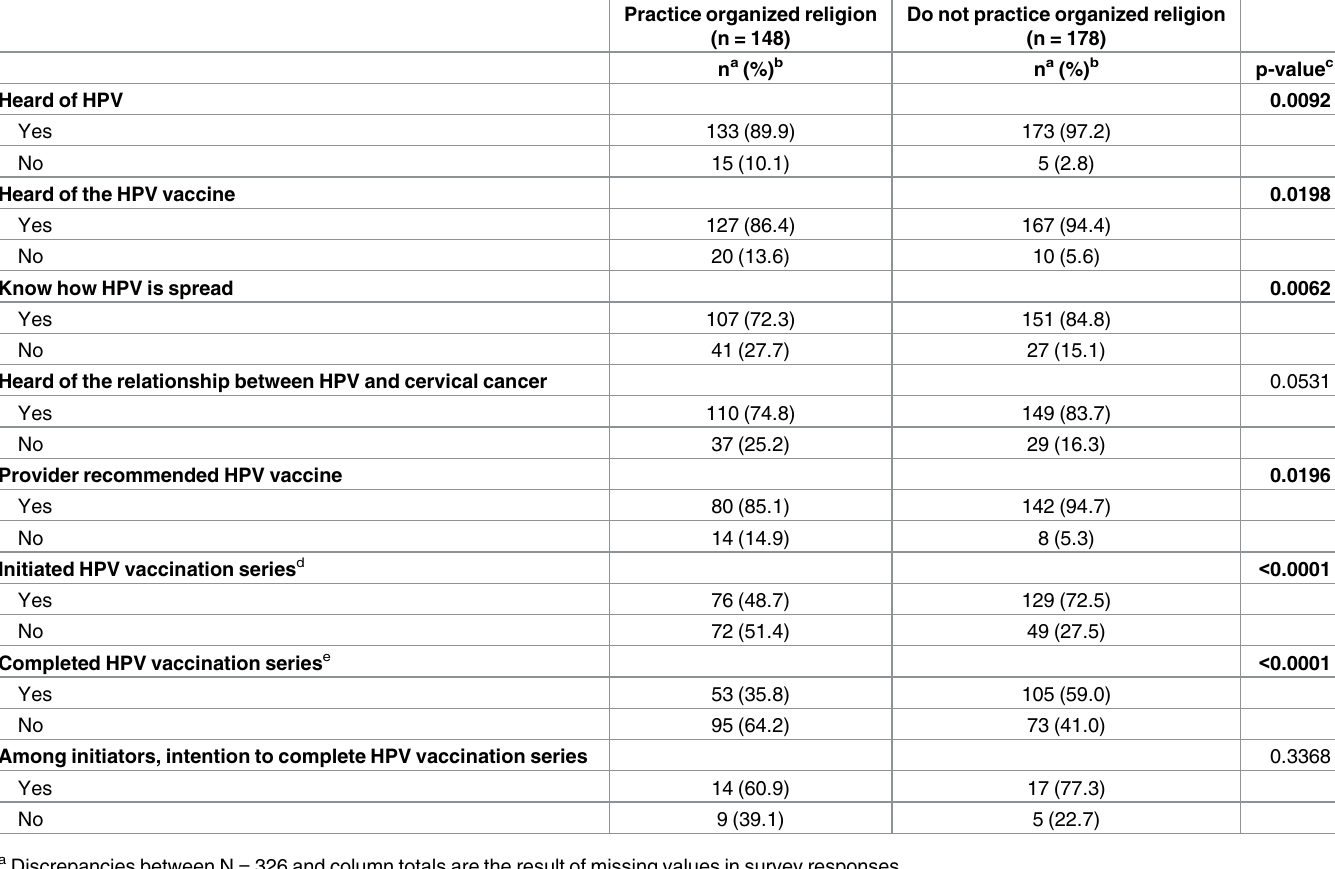
Table 2. HPV vaccine-related awareness, knowledge, beliefs, and receipt among participants by religious practice (N = 326).